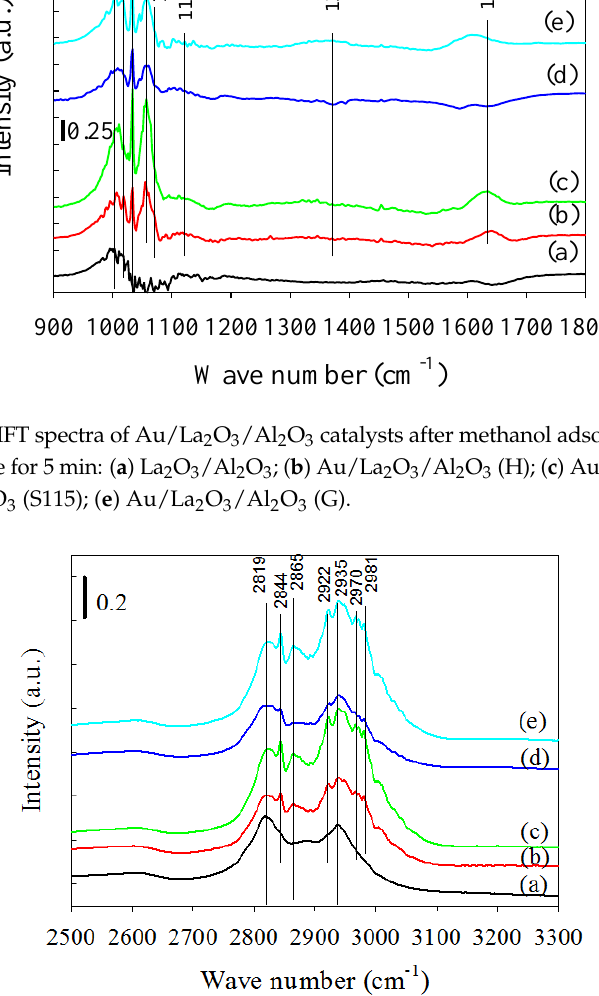
Figure 6. In situ DRIFT spectra of Au/La 2 O 3 /Al 2 O 3 catalysts after methanol adsorption at 160 °C and subsequent He purge for 5 min: (a) La 2 O 3 /Al 2 O 3 ; (b) Au/La 2 O 3 /Al 2 O 3 (H); (c) Au/La 2 O 3 /Al 2 O 3 (S35); (d) Au/La 2 O 3 /Al 2 O 3 (S115); (e) Au/La 2 O 3 /Al 2 O 3 (G).